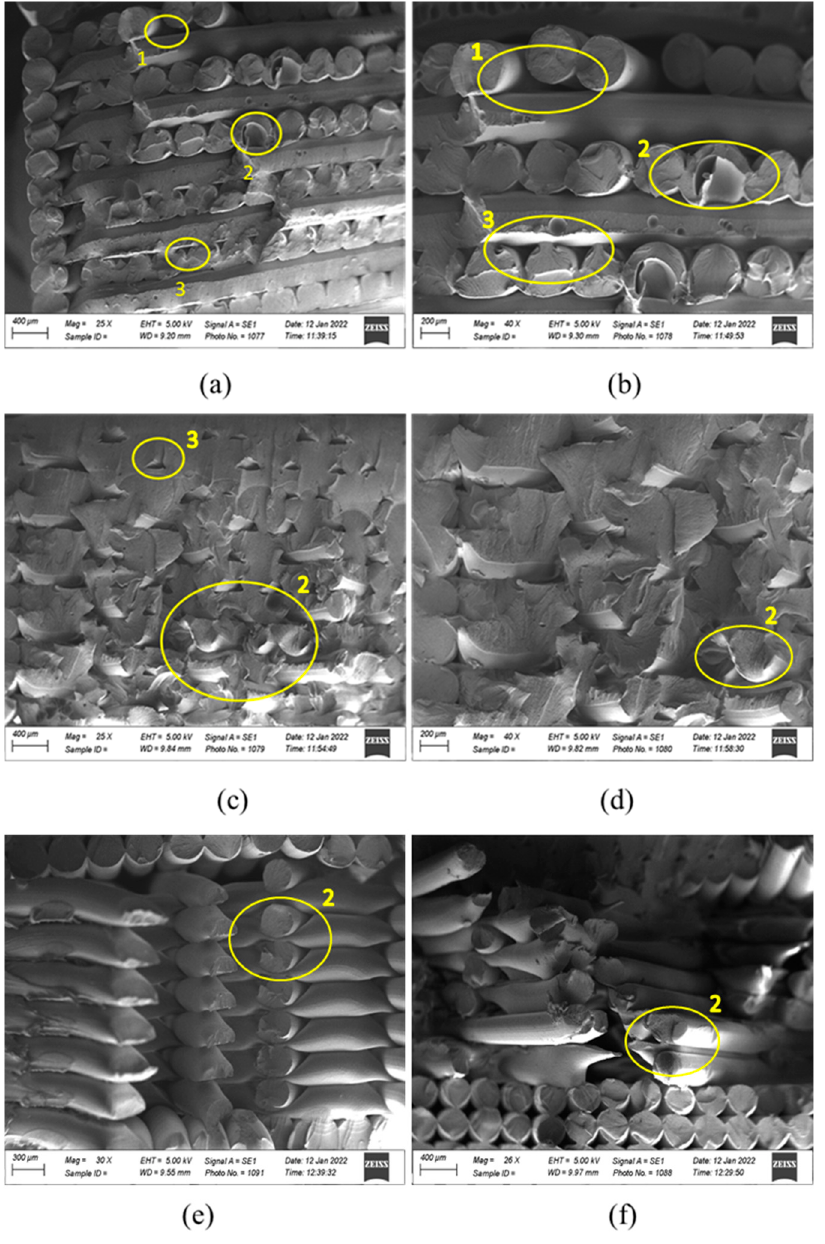
Figure 12. Fractographic analysis of 3D printed Samples ( a ) 75/15 at 25 × magnification; ( b ) 75/15 at 40 × magnification; ( c ) 45/ − 45 at 25 × magnification; ( d ) 45/ − 45 at 40 × magnification; ( e ) quarter-cubic pattern micrograph; ( f ) Tri-hexagon pattern micrograph.